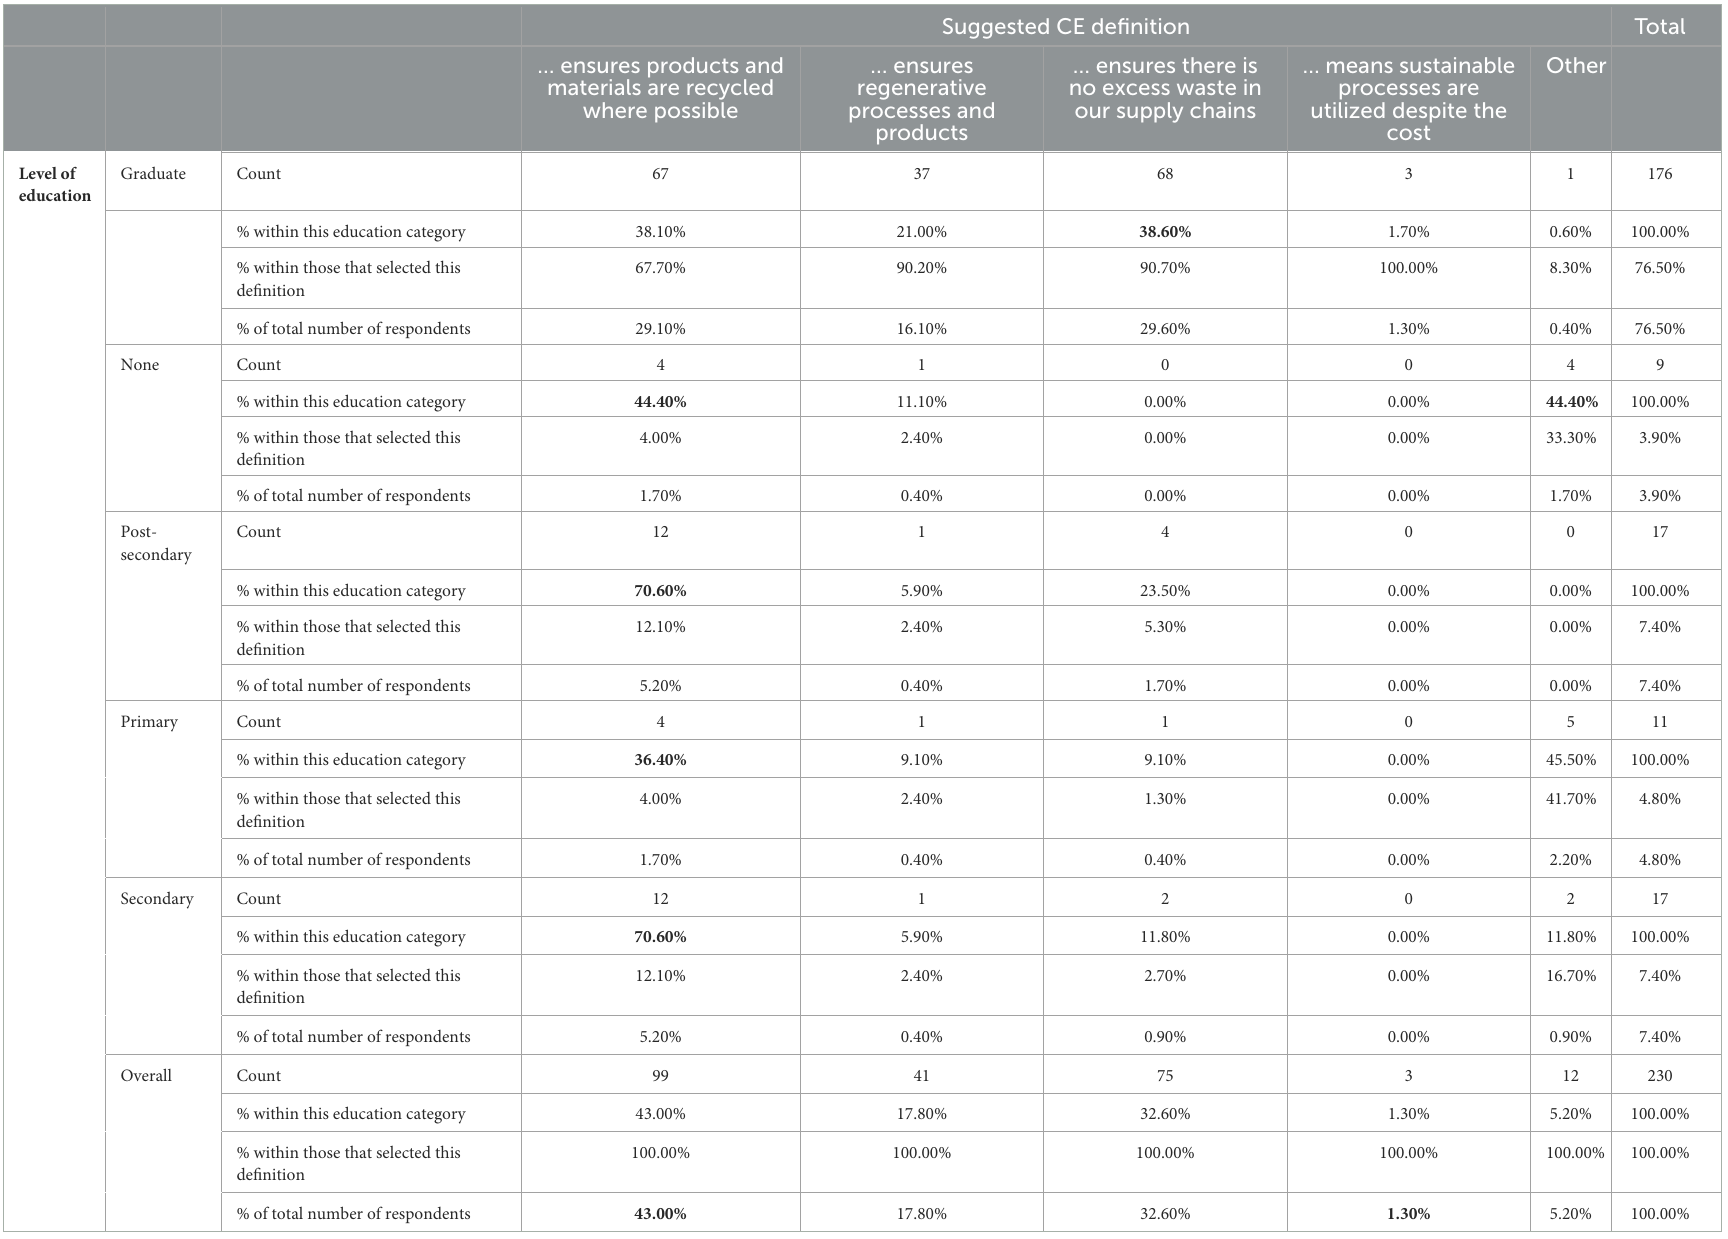
TABLE 2 Variations in CE definition with education